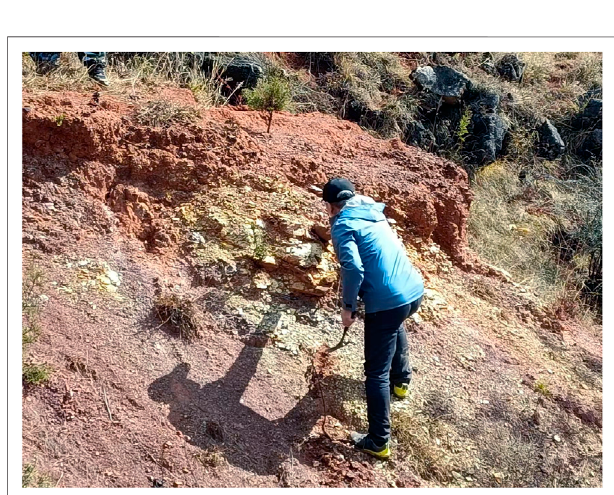
FIGURE 2 | Accumulation-type bauxite deposit in southwest China.